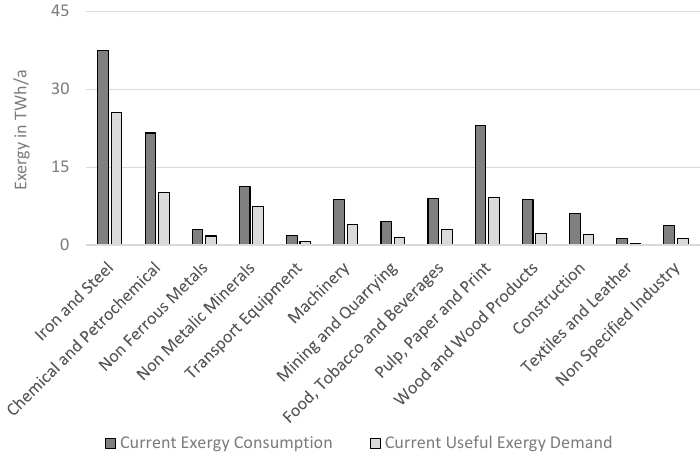
Figure 11. Comparison of the current exergy consumption and current useful exergy demand for different industrial subsectors. The exergetic efficiency for each industrial subsector can be determined by the ratio of these two parameters.